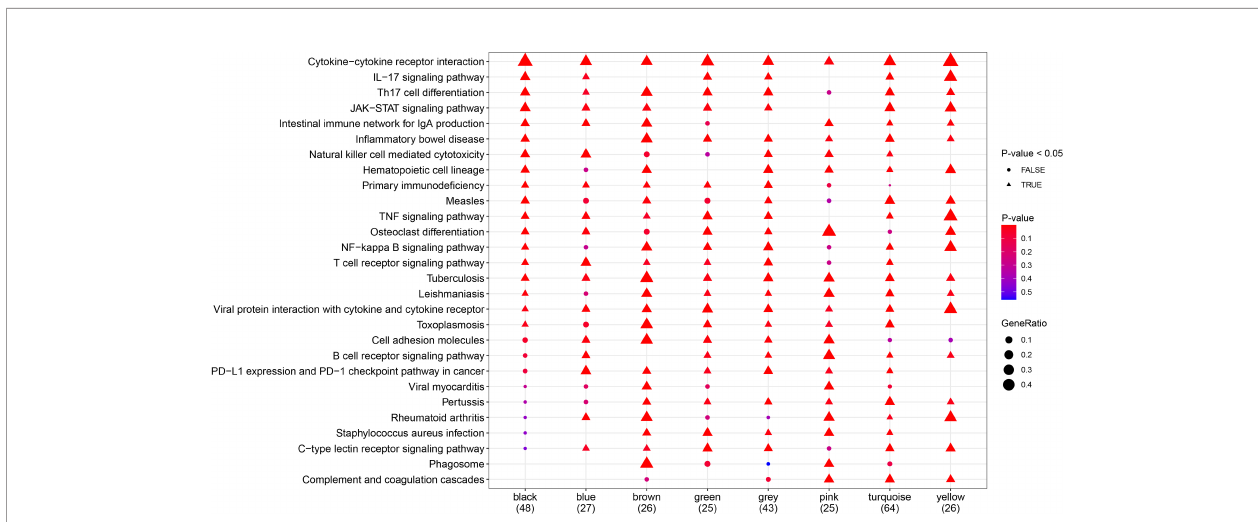
FIGURE 7 | Kyoto Encyclopedia of Genes and Genomes (KEGG) pathway analysis. Demonstration of the pathways most signi fi cantly enriched. Triangles represent statistical signi fi cance (P < 0.05), and circles represent no statistical signi fi cance (P ≥ 0.05). The redder the color, the more signi fi cant the enrichment, and the larger the pattern, the more the genes are enriched. Different molecular subtypes were composed of different gene modules, which corresponded to different